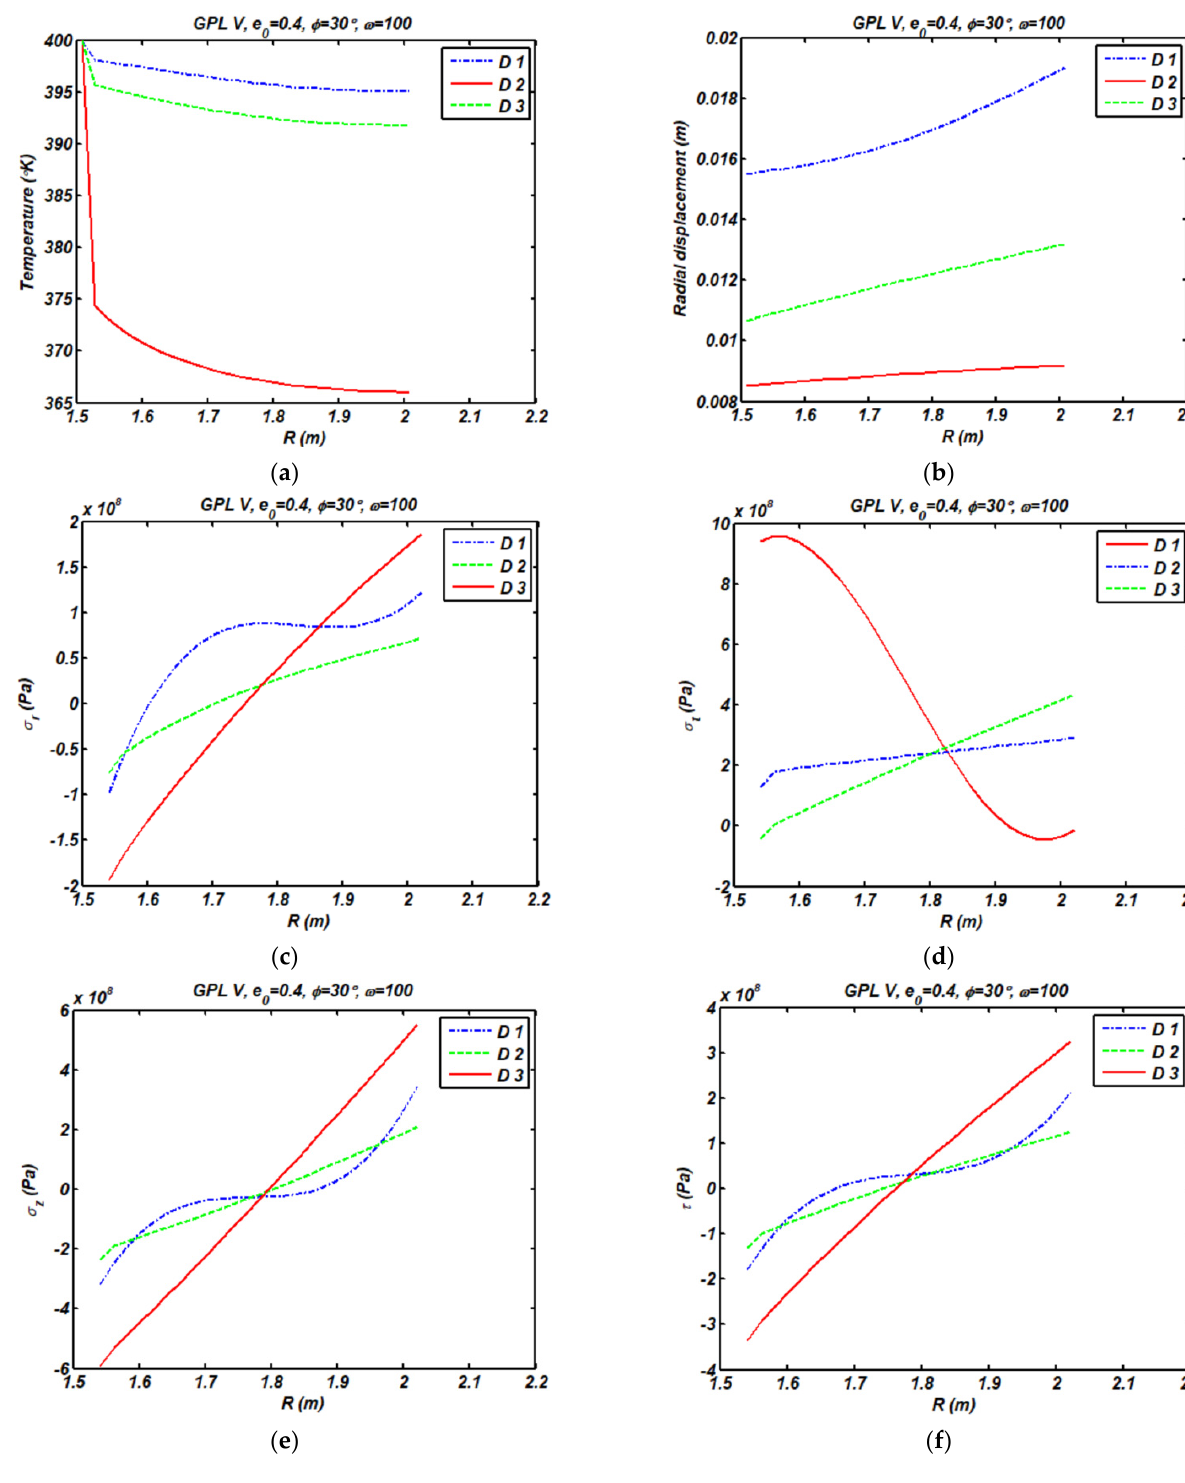
γ ω φ = 30°; GPL = 0.01; = 100 rad/s).